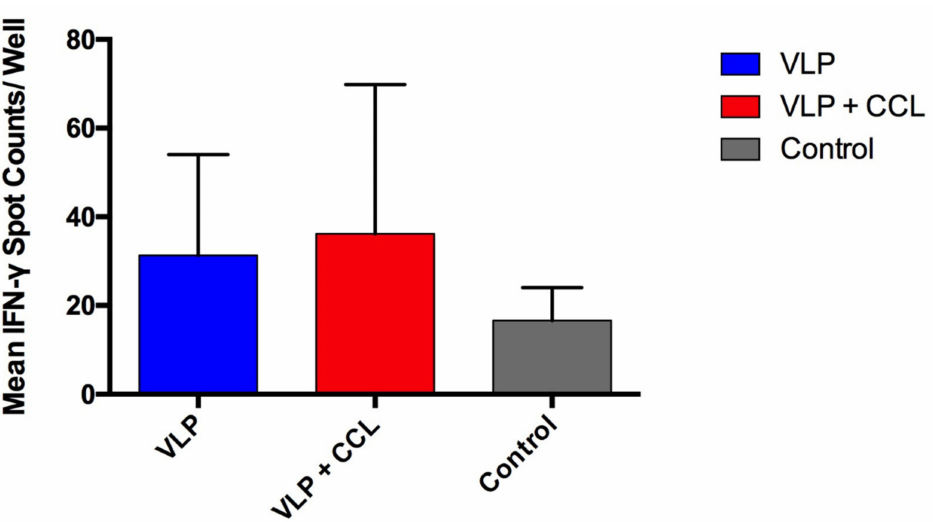
Figure 10. The result of PEDV S-specific Interferon- γ -secreting cell count in the peripheral blood mononuclear cells (PBMCs). The PBMCs were prepared from the peripheral blood of pigs at 49 DPPI. Interferon- γ -secreting cells were enumerated by the ELISPOT assay. The data are shown as mean ± SEM and the results of control, VLP, and VLP + CCL groups are, respectively, illustrated as gray, blue, and red